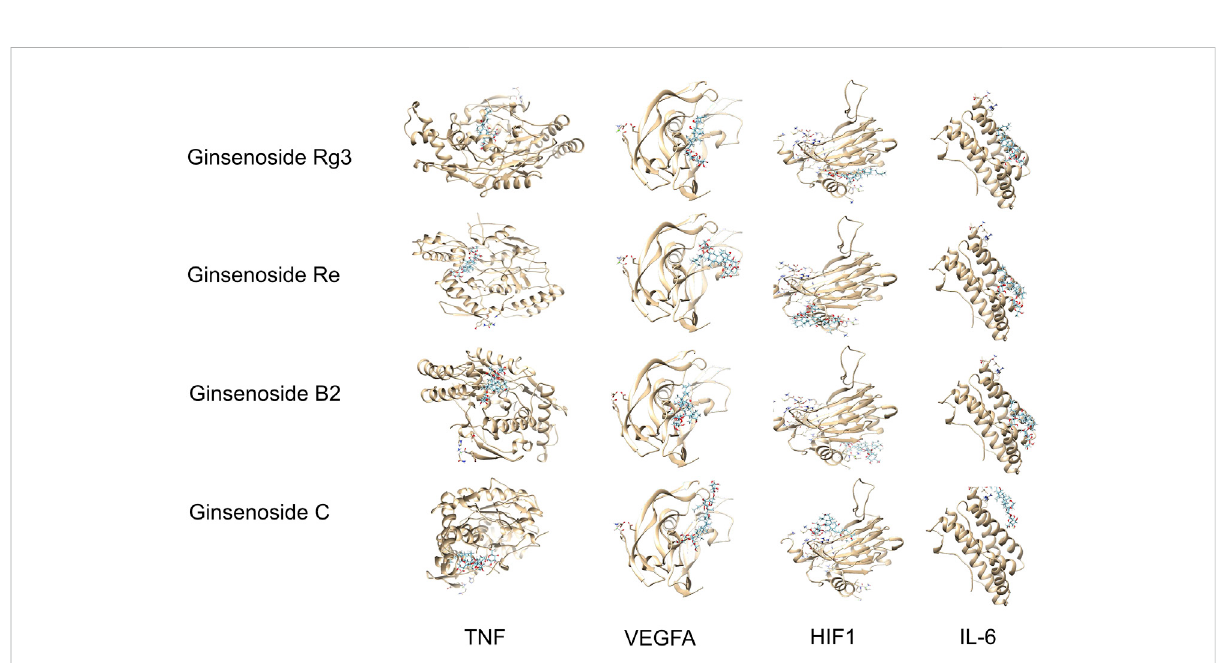
FIGURE 3 Molecular docking results of selected components and